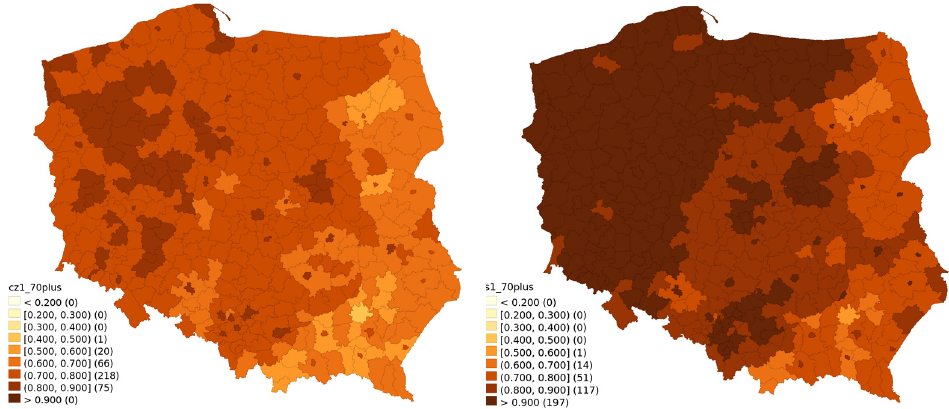
Figure 4. Vaccination rate for the 70 and above age bracket for 30 June 2021 and 31 January 2022.